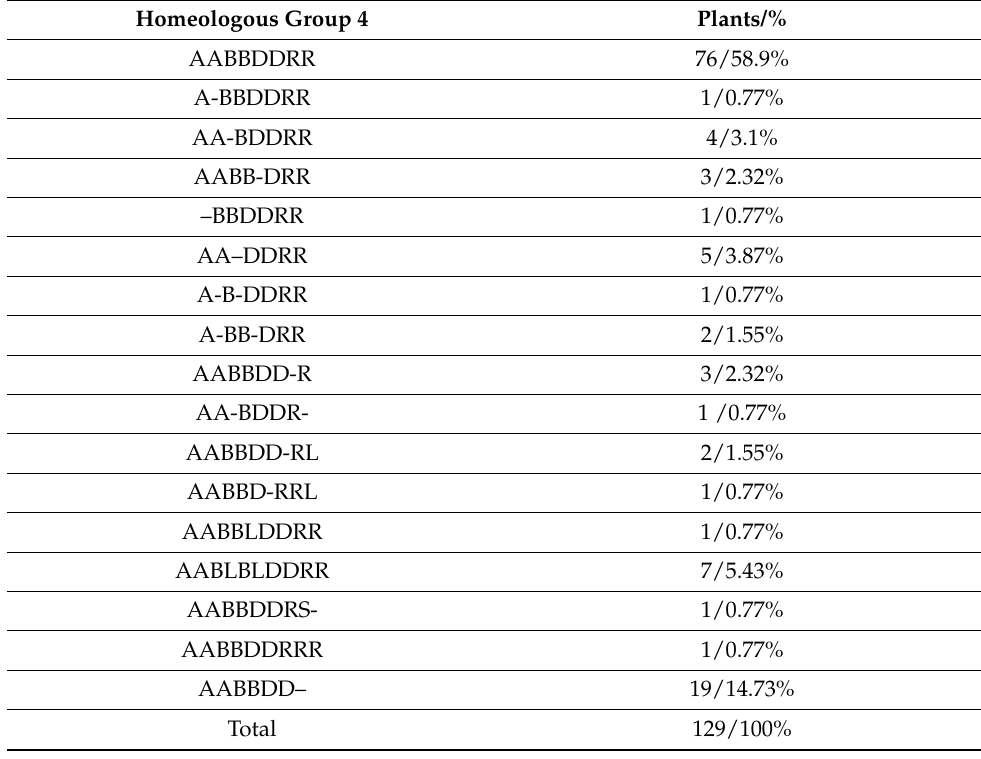
Table 3. Combinations of rye and wheat chromosomes of the 4th homeologous group.